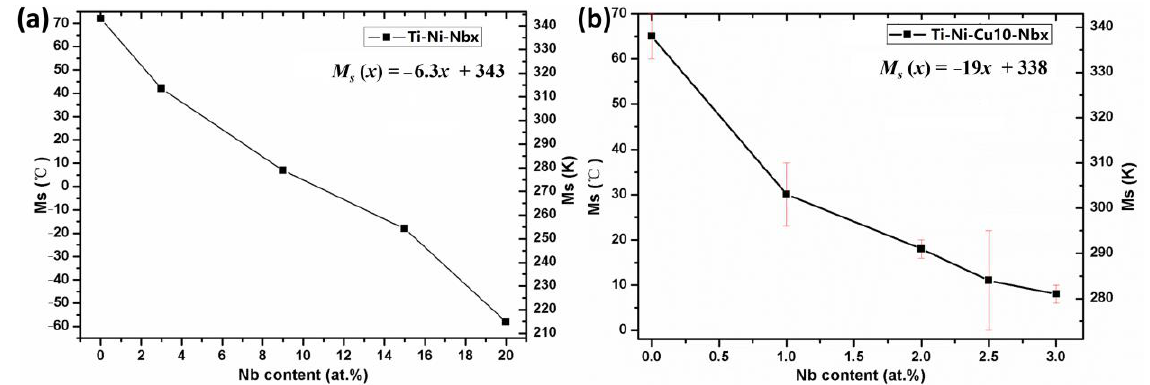
Figure 4. The influence of Nb content on the M s of ( a ) Ti 51 − x Ni 51 − x Nb 2x alloys [7] and ( b ) Ti 51 − 0.5x Ni 39 − 0.5x Cu 10 Nb x alloys produced by SDA shows Nb decreases the M s